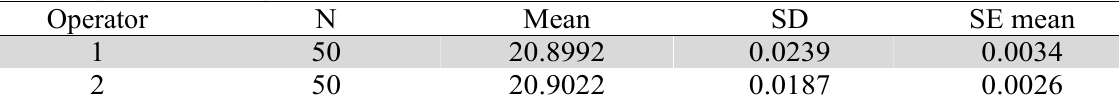
Two Sample t test for operator skill